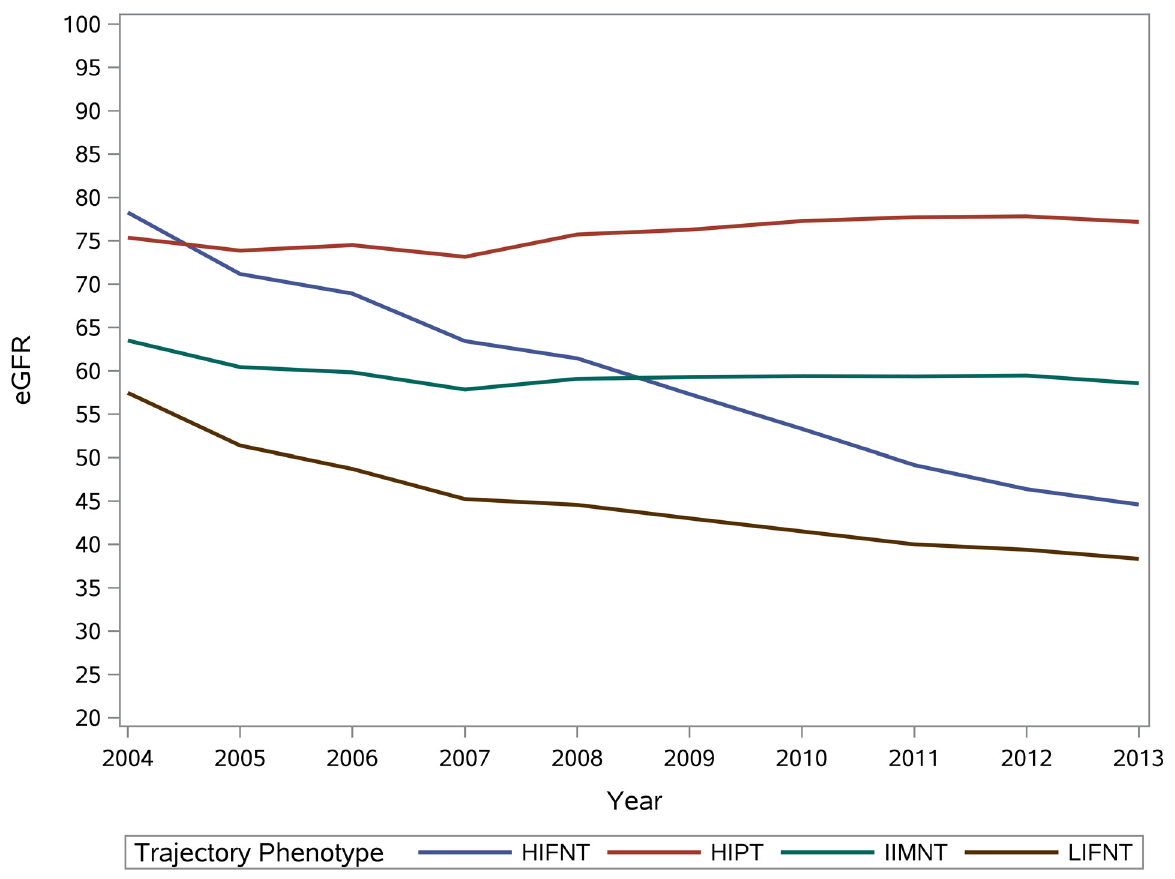
Fig 3. Renal function trajectory